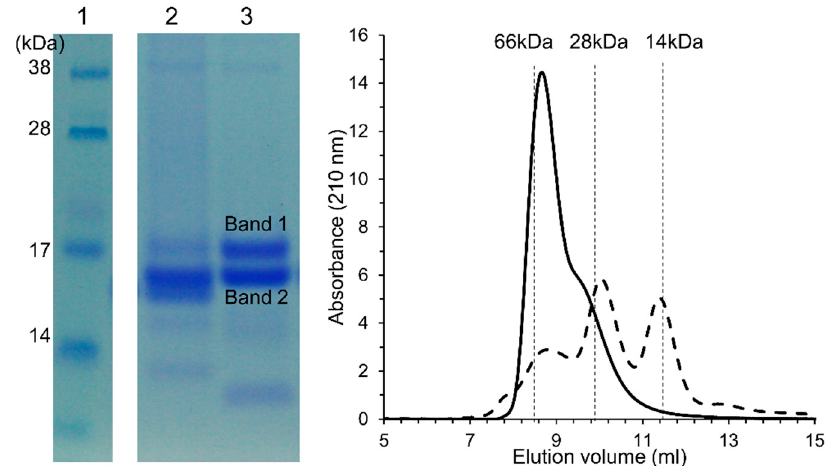
Figure 5. Identification of isolated ATI tetramers. SDS-PAGE of ATI tetramer isolates in the presence of 2% ( m / v ) dithiothreitol. (1) Molecular weight standard, (2) Commercial Sigma ATI control, containing mainly monomeric and dimeric ATI 0.19, 0.28, and 0.53 [14], and (3) ATI tetramer isolate. Size-exclusion chromatogram of ATI tetramer isolate (line) and Sigma ATI (broken line). Elution volume of molecular standard bovine serum albumin 66 kDa (8.6 mL), chymotrypsinogen 25.6 kDa (9.9 mL), and lysozyme 14 kDa (11.4 mL). As determined by mass spectrometry, Band 1 consists of the ATI tetramer CM3 subunit and Band 2 of the ATI tetramer CM2 subunit.